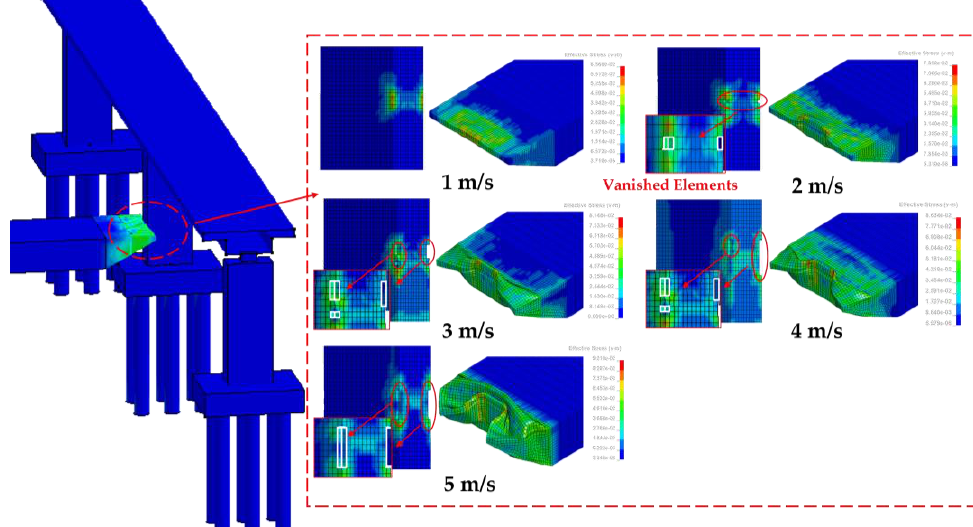
Figure 13. Barge – whole bridge stress nephograms at different impact velocities.